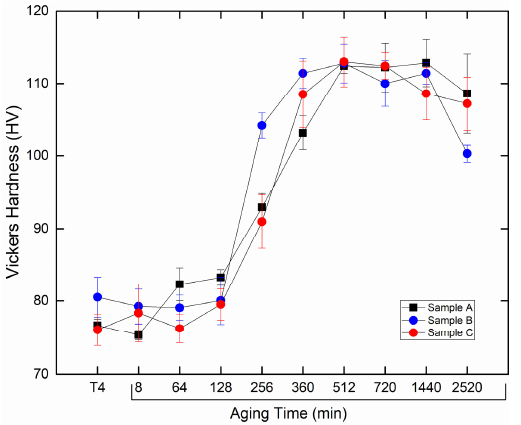
Figure 7. Vickers hardness values for solutioned and different artificially aged times.